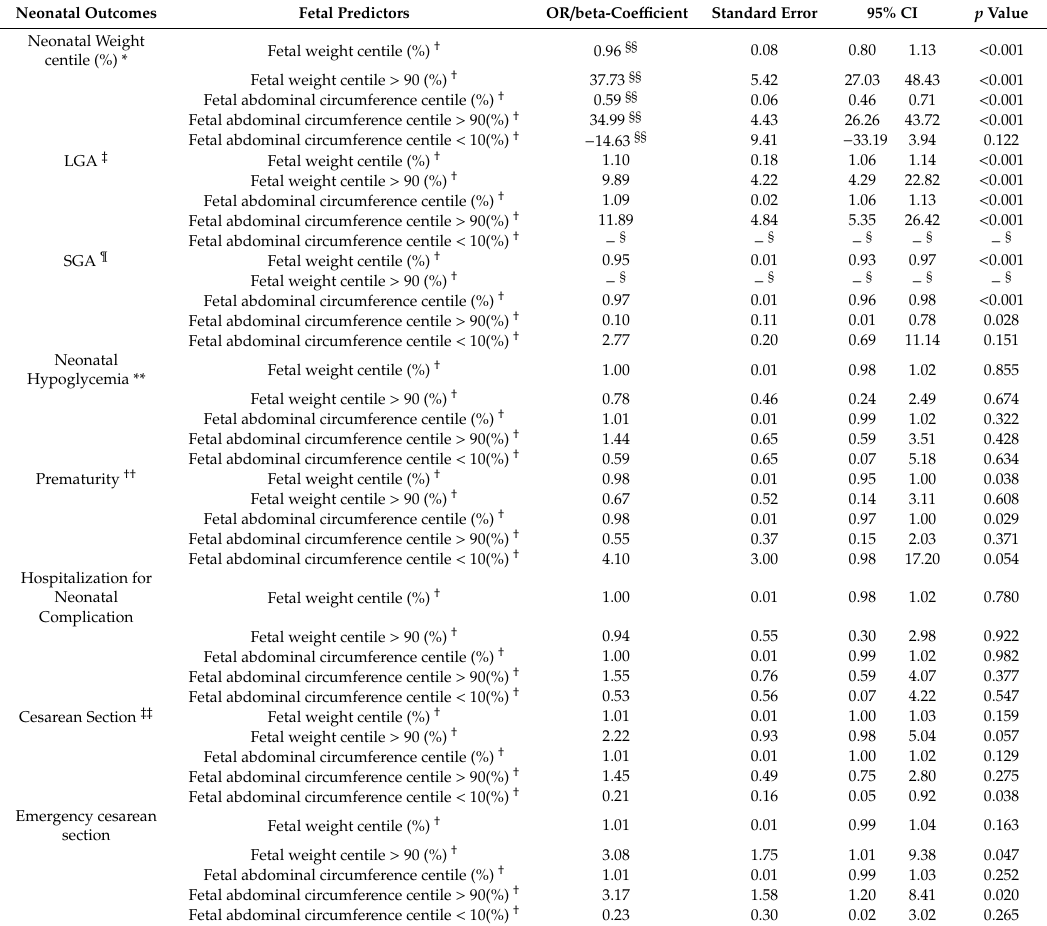
Table A2. Fetal predictors of adverse neonatal